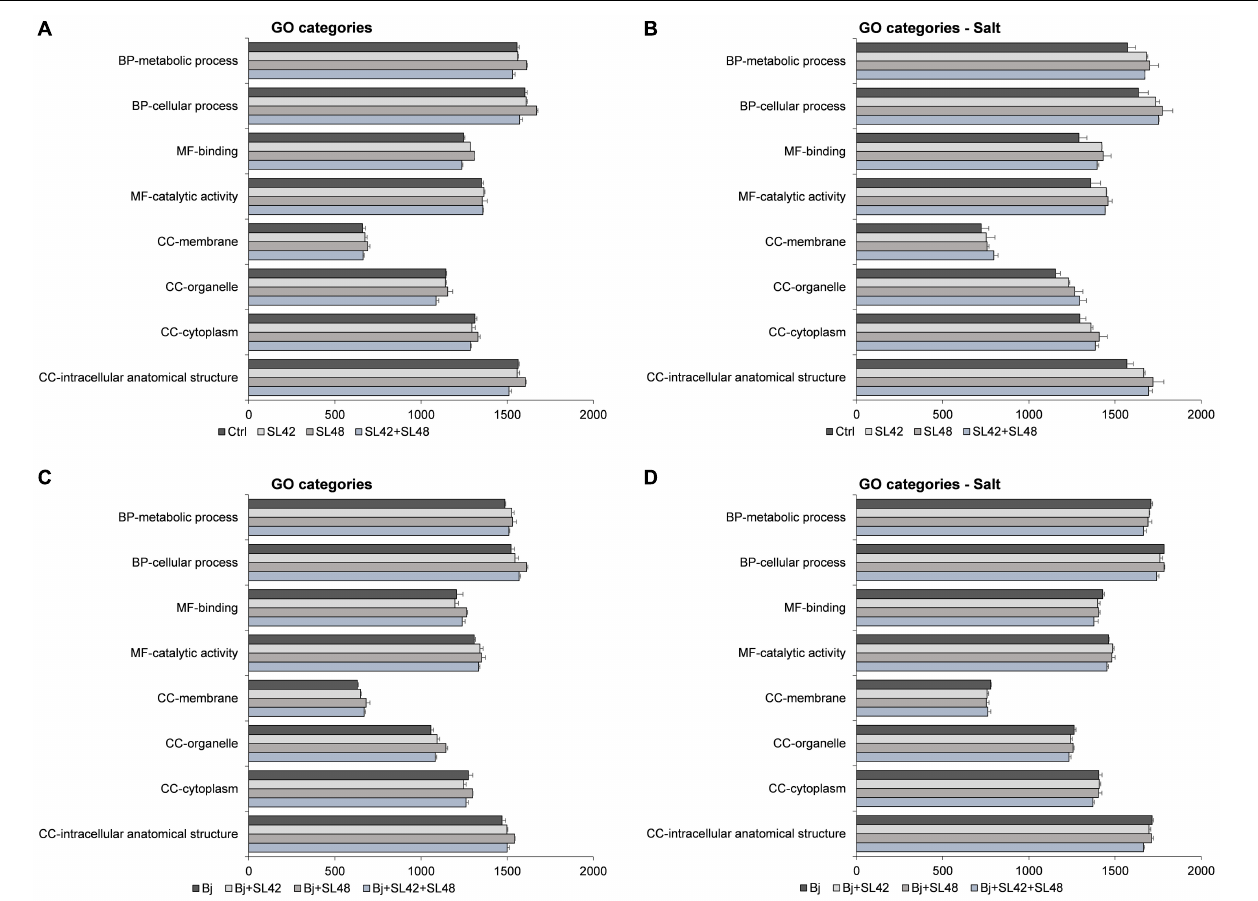
FIGURE 6 | Number of sequences involved in the major GO categories of the soybean leaf proteome. (A) The seeds were treated with 10 mM MgSO 4 or bacterized with the strains Rhizobium sp. SL42, Hydrogenophaga sp. SL48 or co-inoculated under optimal and (B) under salt stress conditions. (C) Seeds were bacterized with Bradyrhizobium japonicum (Bj) as control or the strains were co-inoculated with Bj under optimal and (D) under salt stress conditions. Values represent mean ± SE ( n =